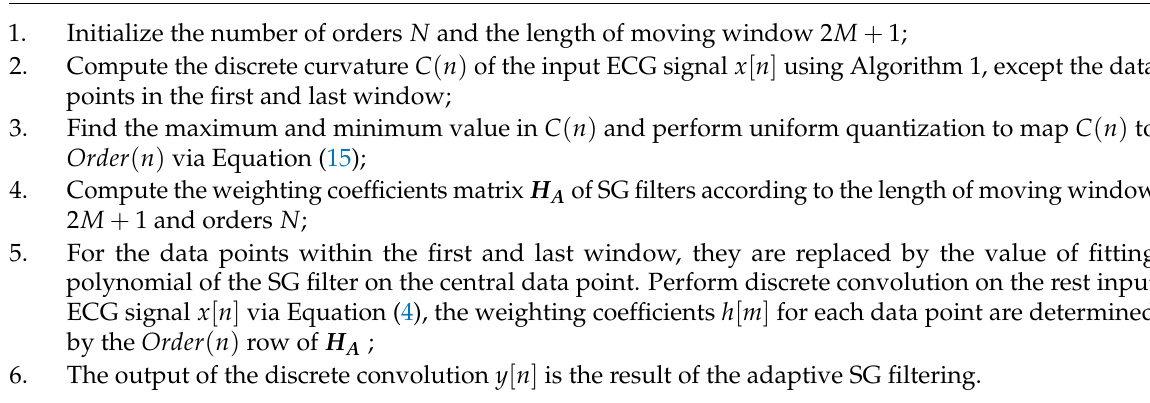
Algorithm 2 LDASG filtering for ECG